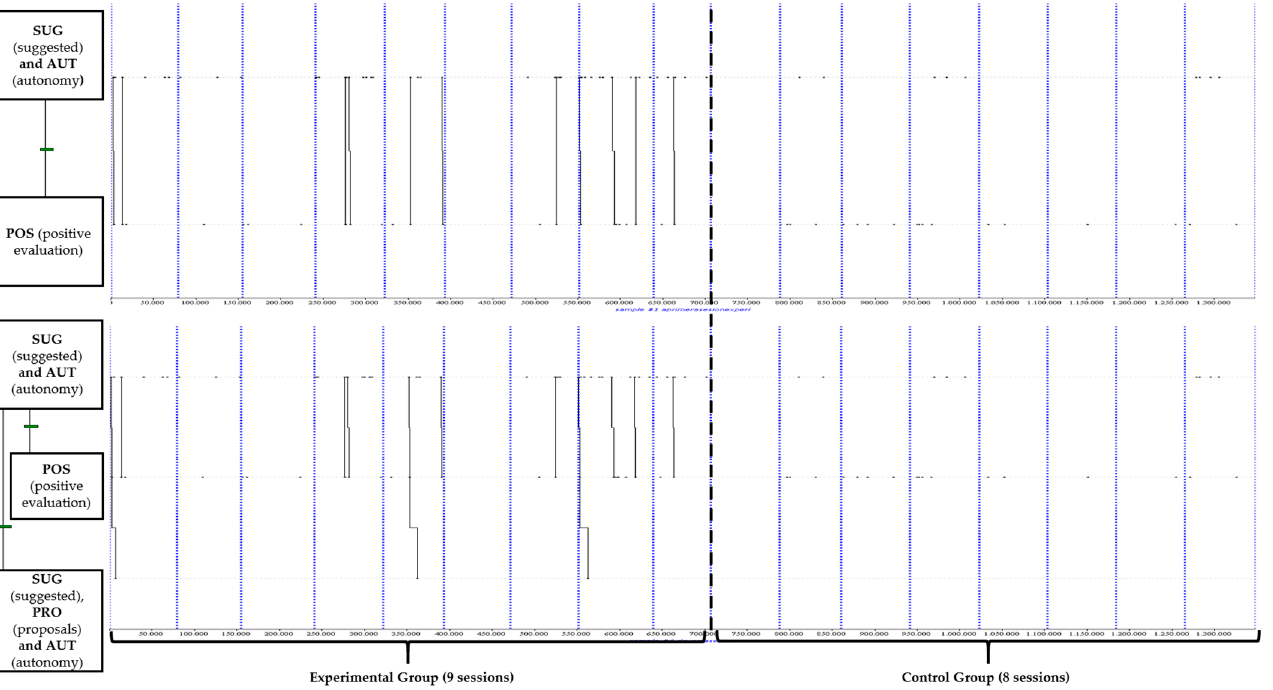
Figure 3. Dendogram representing the comparison of temporal patterns of teachers (EG and CG) associated with innovative teaching behaviours (guide to learning), and student responses.